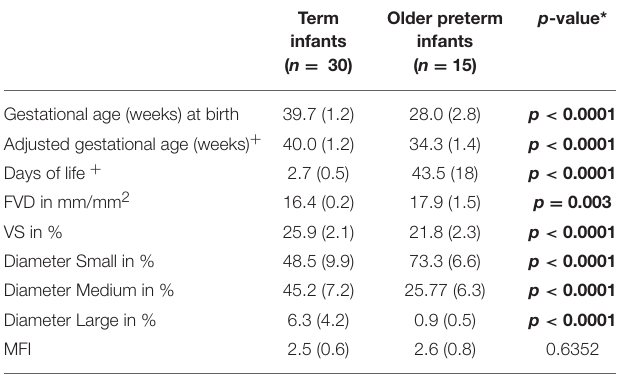
TABLE 5 | Comparison of term and older preterm